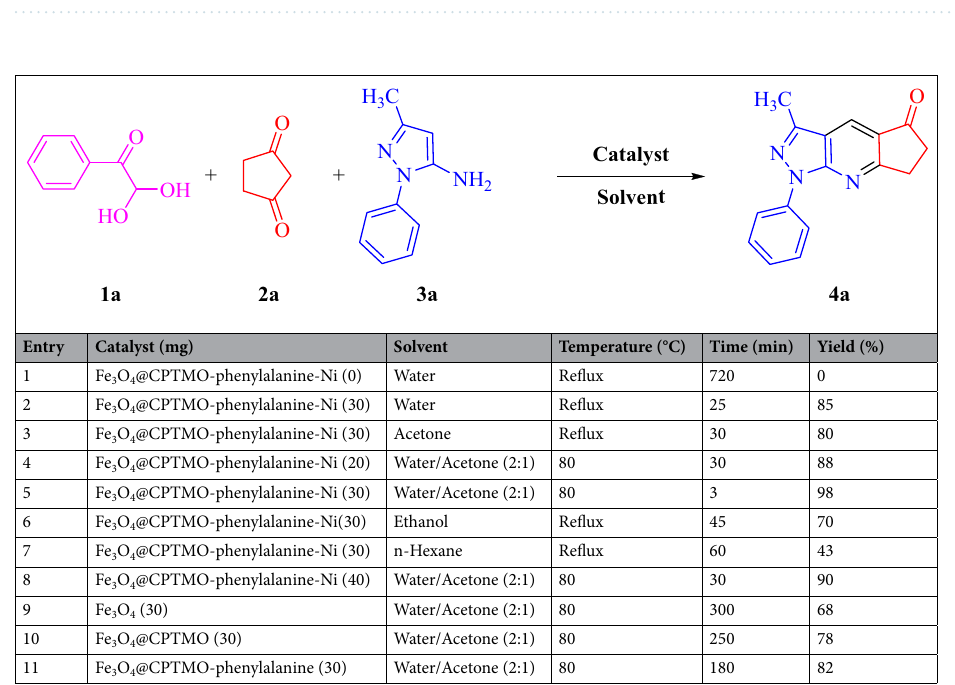
Figure 10. TEM analysis of Fe 3 O 4 @CPTMO-phenylalanine-Ni.